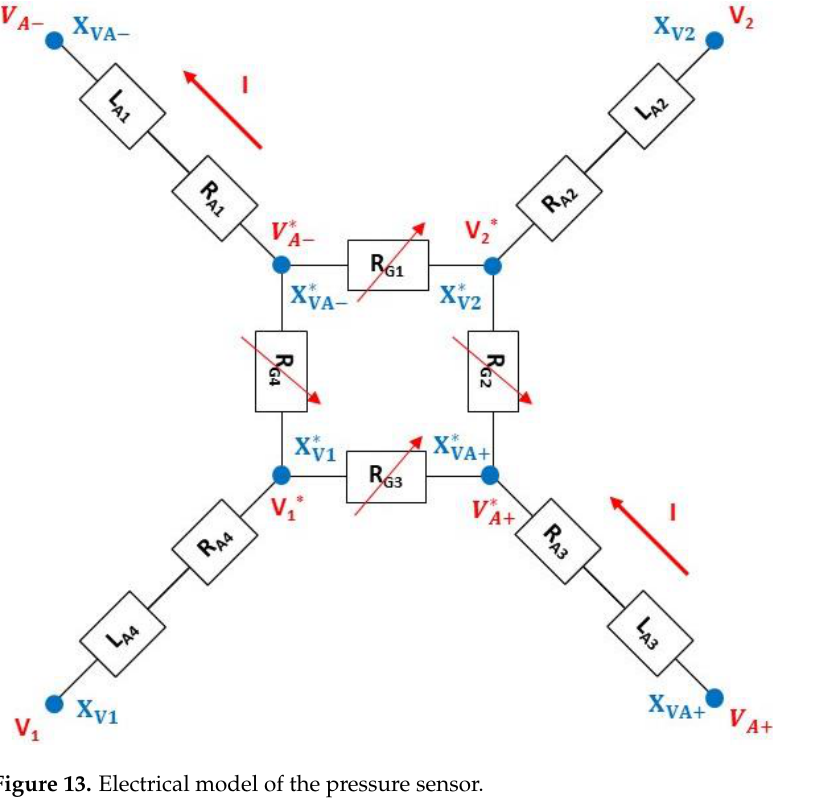
12 of 25 Figure 12. Photographs of the transducer die on its TO3 stainless steel holder. 4.3. Electrical Model and Simulation Results The electrical model of the pressure transducer is shown in Figure 13 and includes the following two main parts: •